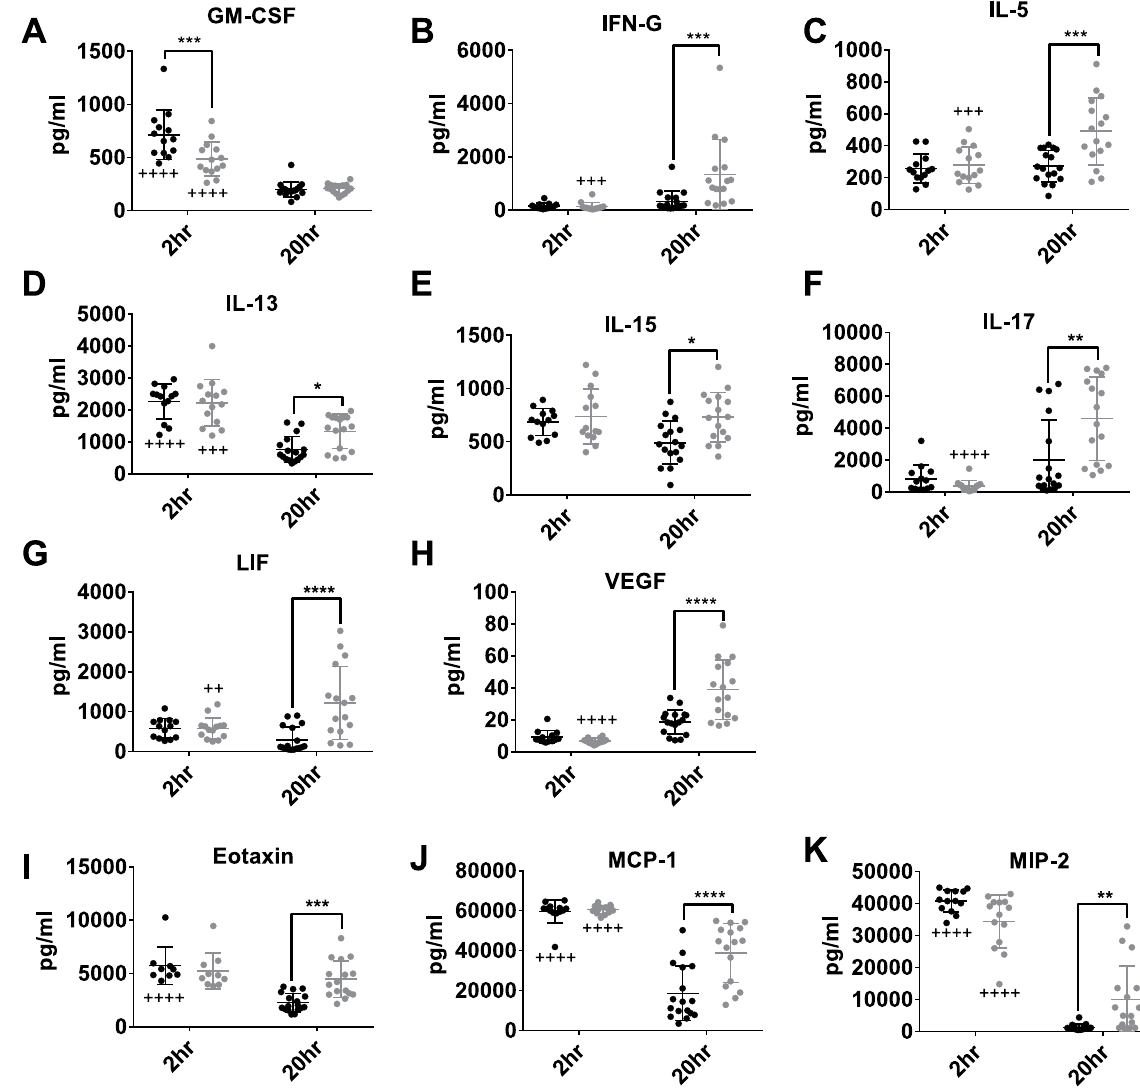
Figure 3. Serum cytokine expression suggests lack of resolution in post-pubertal animals. Serum samples obtained via cardiac puncture from pre- and post-pubertal C57Bl/6 mice (N ≥ 9/group) were subjected to a 32- plex cytokine assay. The 12 cytokines above show significant differences in expression between pre- and post- pubertal mice at either the (A) 2-hour time point or (B–K) 20-hour time point. For all graphs, pre- and post- pubertal data are shown in black and grey closed circles respectively. Data points above or below the detectable limit of the assay were not included. Significant age-associated differences in cytokine concentration are labelled with **** (p < 0.0001), *** (p < 0.001), ** (p < 0.01), or * (p < 0.05). Significant changes in concentration between 2 and 20 hours for either pre- or post-pubertal mice are labelled with ++++ (p < 0.0001), +++ (p < 0.001), or ++ (p < 0.01). All comparisons were made using Two-way ANOVA followed by Tukey’s multiple comparisons